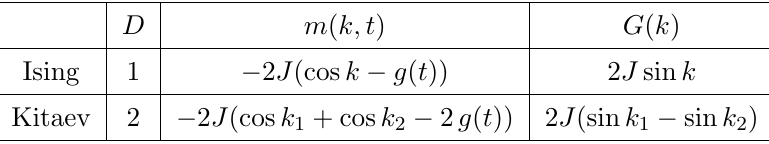
Table 1 . Couplings for lattice